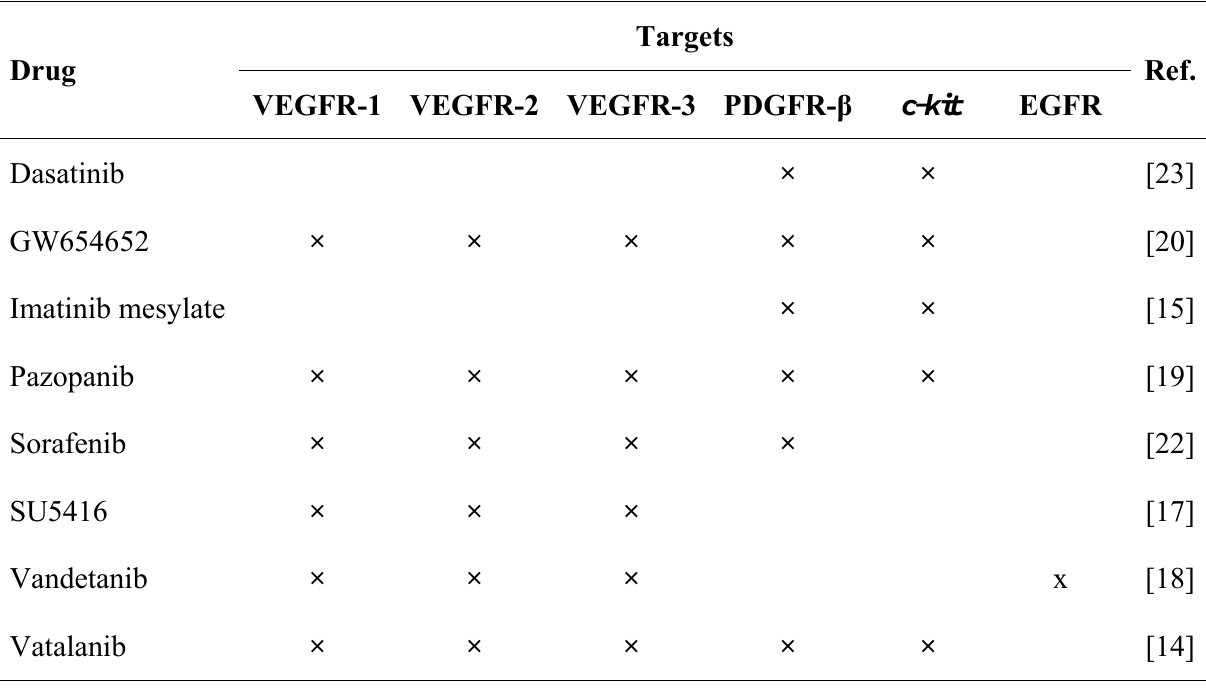
Table 1. Kinase inhibitors in clinical trials for multiple